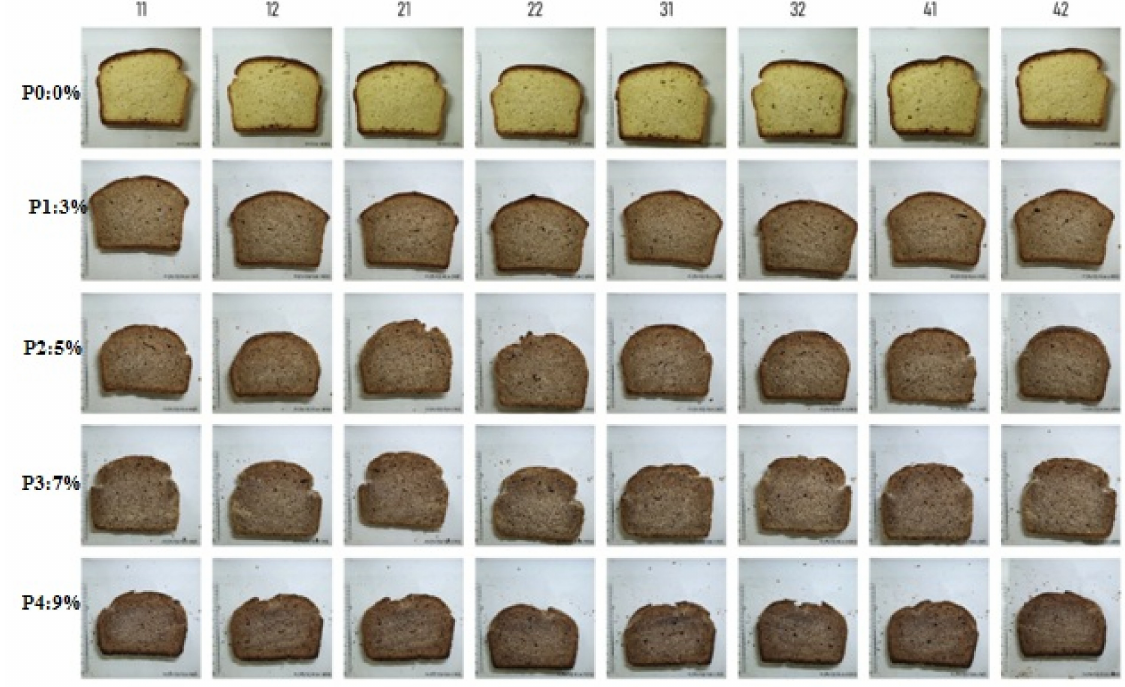
Figure 2. Bread slices of samples P0, P1, P2, P3, and P4.